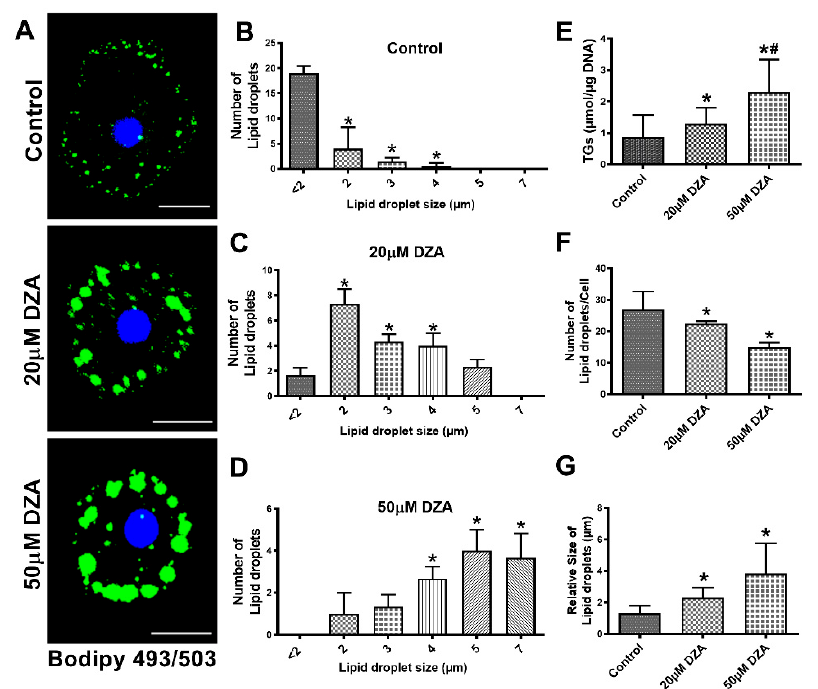
Figure 1. Characterization of LDs in control and DZA-treated hepatocytes. ( A ) Accumulation of LDs in control and DZA-treated hepatocytes determined by BODIPY staining (Scale bar 20 µ m). ( B ) Distribution of di ff erent sized LDs in control, ( C ) 20 µ M DZA, and ( D ) 50 µ M DZA-treated hepatocytes, n = 4 experiments; images of 30 random cells from each treatment group per experiment were captured and analyzed for their LD numbers and size (in diameter) (* p ≤ 0.05 vs. < 2 µ m). ( E ) Triglyceride levels in control and DZA-treated hepatocytes, n = 11 experiments. ( F ) Total number of LDs per cell in control and DZA-treated hepatocytes, n = 4 experiments; images of 30 random cells from each treatment group per experiment were captured and analyzed for LD number / cell. ( G ) LD size (in diameter) in control and DZA-treated cells, n = 4 experiments; images of 30 random cells from each treatment group per experiment were captured and analyzed for LD size / cell. Asterisks indicate values for DZA-treated hepatocytes are statistically di ff erent from controls at * p ≤ 0.05 vs. Control; # p < 0.001 vs.